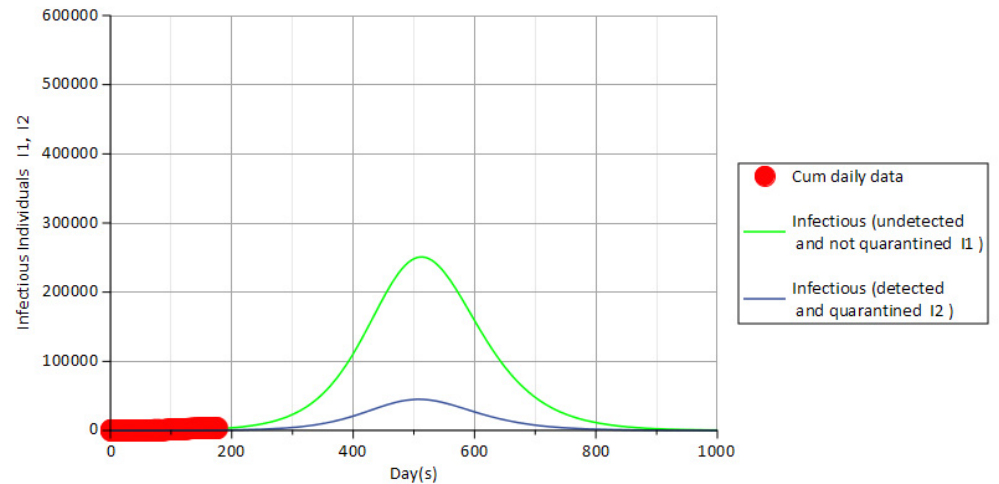
Figure 8. Effect of mass media value σ m = 0.62 with cumulative daily infectious individuals (red), I 1 ( t ) (green) and I 2 ( t ) (blue) using other parameters as in Table 3